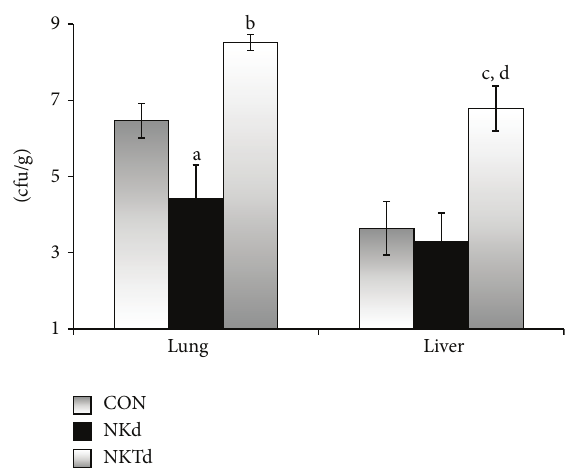
Figure 2: Tissue outgrowth of Streptococcus pneumonia . Bacterial growth was measured in the lower lobe of the right lung and in the liver after animal sacrifice 48 hours after bacterial challenge with Streptococcus pneumoniae . Mice were pretreated with nonspecific IgG (CON, 𝑛 = 6 ); with anti-asialo GM1 antibody (NKd, 𝑛 = 8 ); or with anti-CD1d antibody (NKTd, 𝑛 = 10 ). Statistically significant comparisons after corrections for multiple tests are : 0.044; b 𝑝 : 0.033; c 𝑝 : indicated: a 𝑝 NKTd VS NKd NKTd VS CON NKd VS CON : 0.037; d 𝑝 NKTd VS NKd